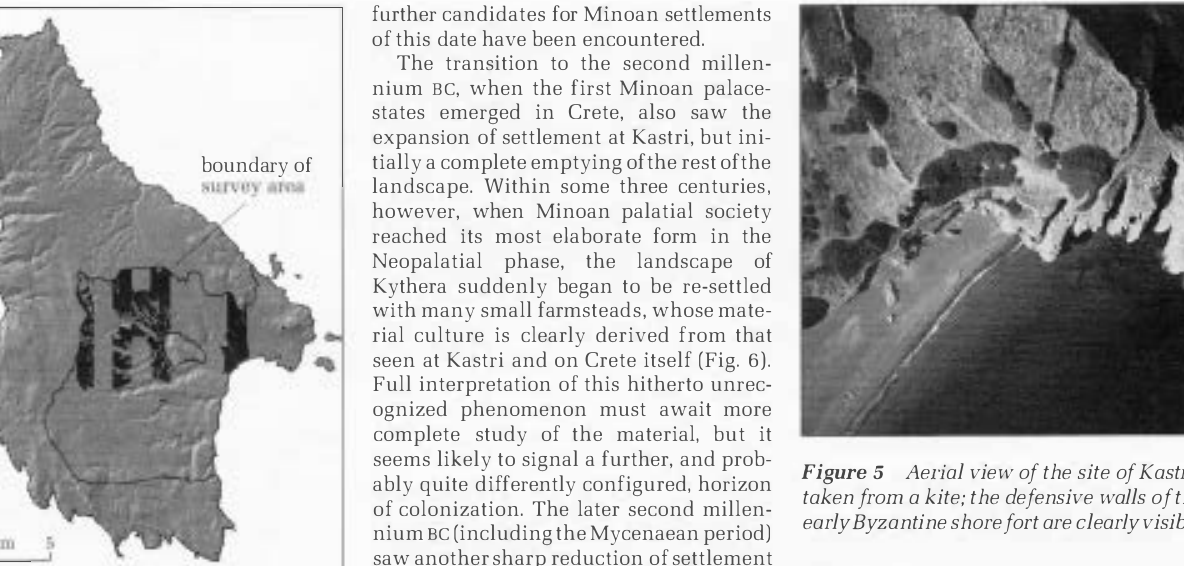
Figure 4 Map of Kythera, generated by GIS, showing the extent of the survey area and of the tracts (solid black) within it that were fieldwalked in 1 998-99.